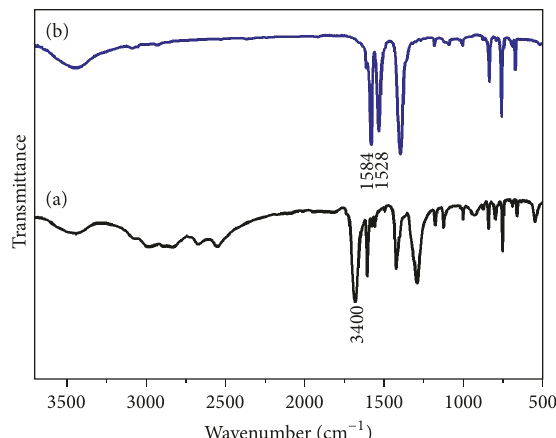
Figure 2: FT-IR spectra of (a) bpdc and (b)